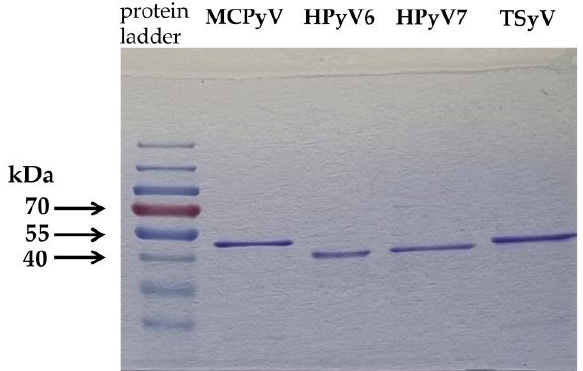
Figure 1. Analysis of the MCPyV, HPyV6, HPyV7 and TSPyV major capsid protein production using Coomassie brilliant blue-stained SDS-PAGE (sodium dodecyl sulphate – polyacrylamide gel electrophoresis). In lanes (from left to the right): 1, PageRuler Pre-stained Protein Ladder, 10 – 180 kDa (Thermo Fisher Scientific, Waltham, MA, USA); 2, MCPyV (Merkel cell polyomavirus) major capsid protein; 3, HPyV6 (Human polyomavirus 6) major capsid protein; 3, HPyV7 (Human polyomavirus 6) major capsid protein; 4, TSPyV (Trichodysplasia spinulosa-associated polyomavirus) major capsid protein.